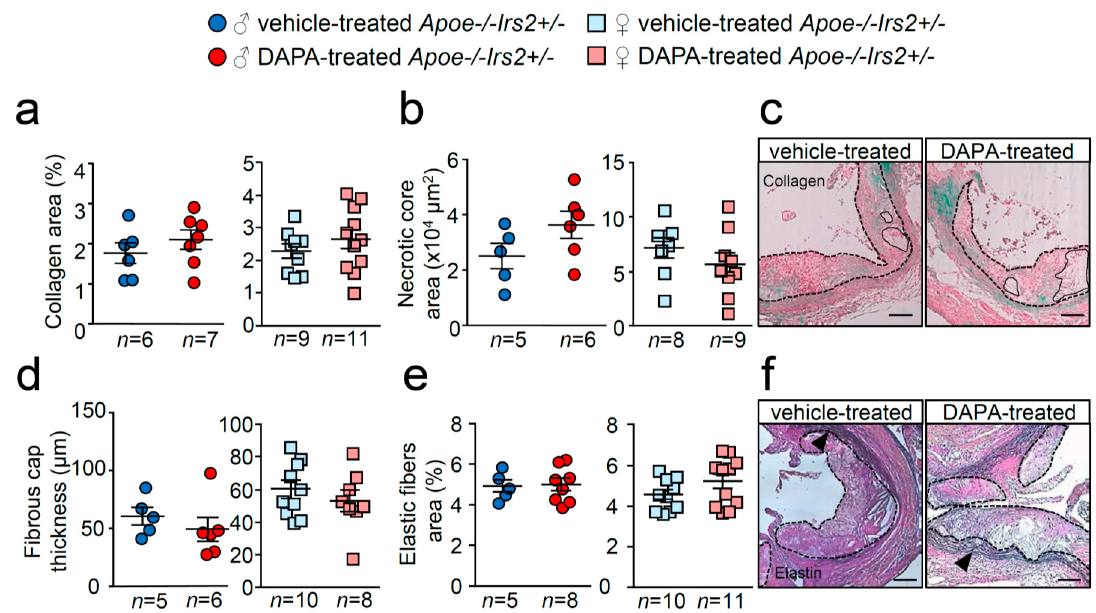
Figure 6. Effect of DAPA in atheroma plaque characteristics of Apoe − / − Irs2+/ − mice. ( a ) Collagen content (in percentage), ( b ) necrotic core area (in µm 2 ) and ( d ) fibrous cap thickness (in µm) determined in Masson trichrome stained lesions from vehicle- and DAPA-treated male (left panels) and female (right panels) mice. ( e ) Elastin fibres’ area assessed in Verhoeff-Van Gieson cross-sections and displayed as percentage of area relative to lesion area in male and female mice. Representative images of Masson trichrome ( c , f ) Verhoeff-Van Gieson stainings. Black arrows in ( f ) point to elastic fibre’s breaks in the media. The dashed lines delineate the limits of the lesion and solid lines delineate the limits of representative necrotic cores. Scale bar: 100 µm. The statistical analysis for normal distribution was Kolmogorov–Smirnov test and for differences was the Student’s t -test ( a , b , d , e , right panels) and Mann–Whitney U test ( a , b , d , e , left panels).